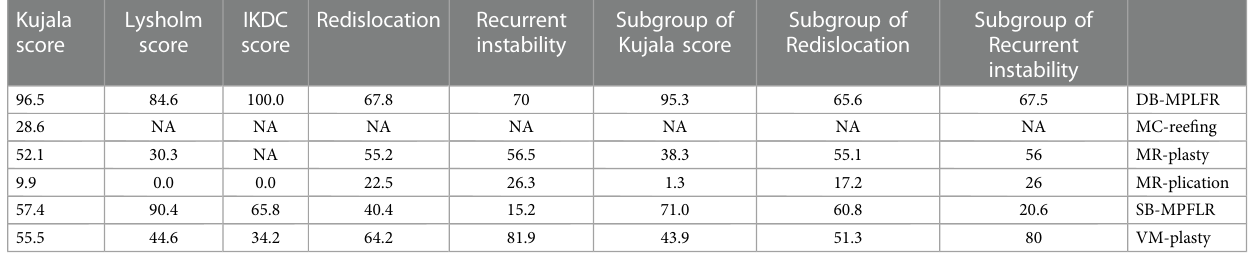
TABLE 3 Ranking of surgeries based on probability of their protective effects on all outcomes according to the SUCRA. Larger probability, stronger protective effects. Kujala Lysholm IKDC score score